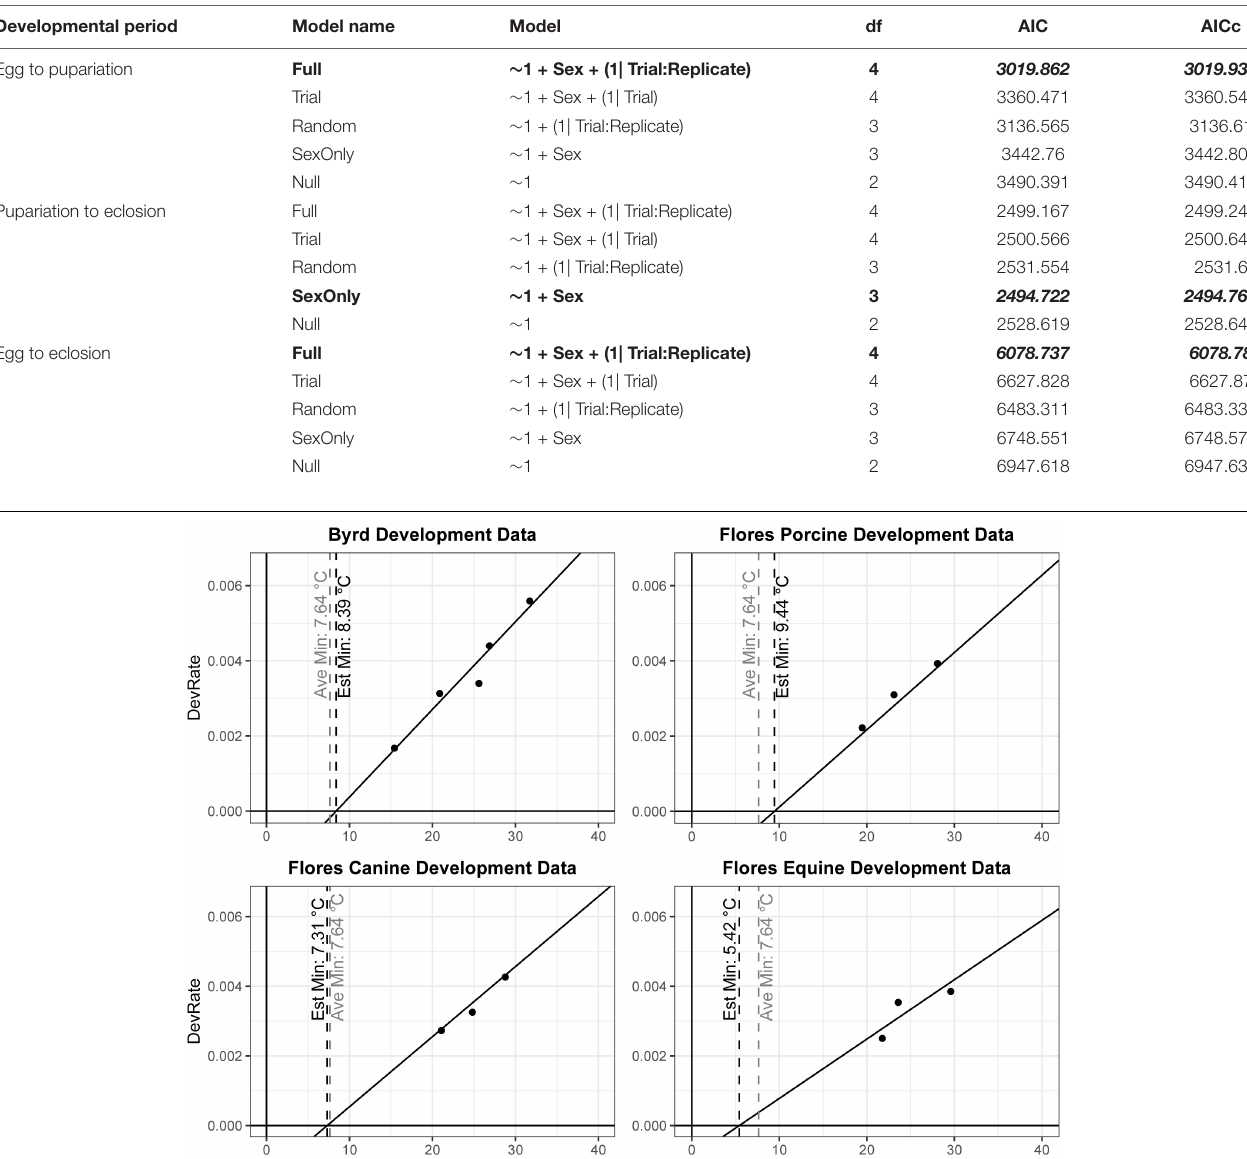
TABLE 1 | Best fit model selection AIC and AICc results testing for sexual dimorphism in development rate at 30 ◦ C for Chrysomya rufifacies. Developmental period